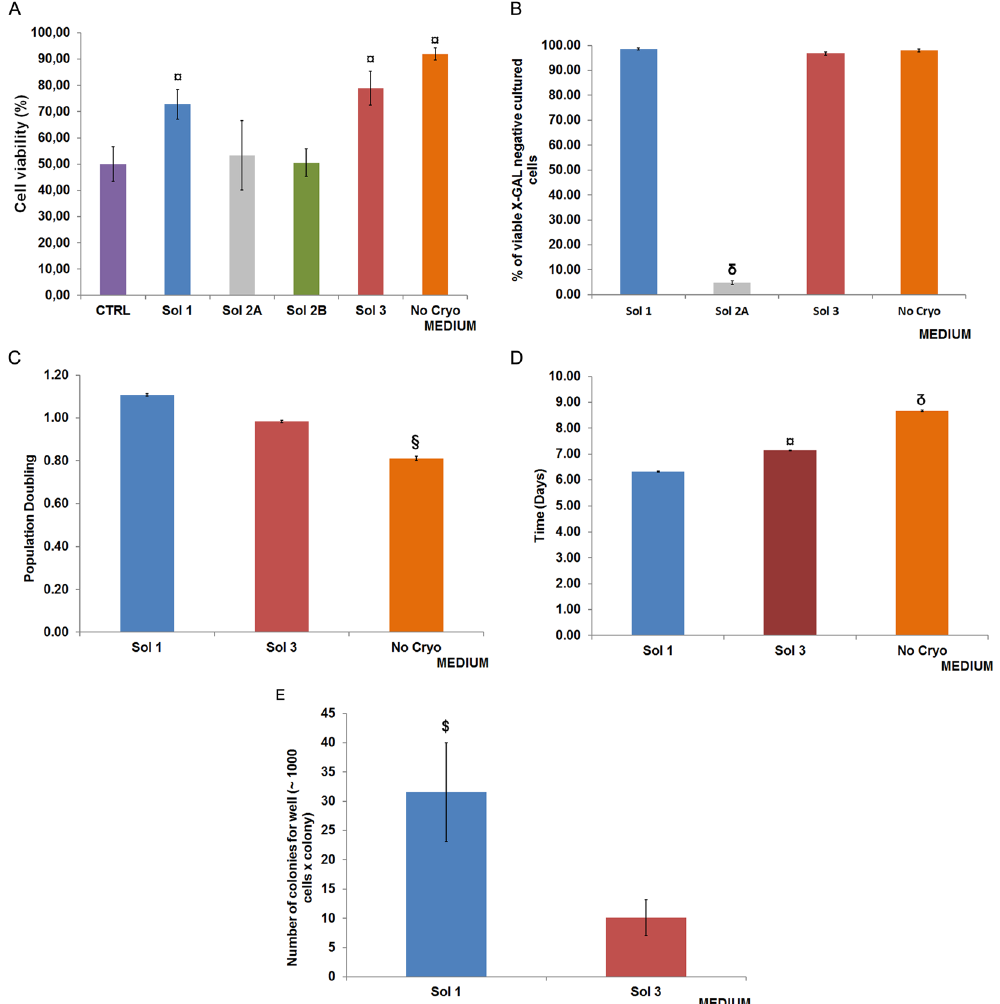
Figure 1. Biological cell functions after cryopreservation/thawing. ( A ) Cell viability was assessed by Trypan blue exclusion test after thawing the cells cryopreserved in different solutions (N = 9 experiments). Viability was significantly higher in solution 1 (Sol1) and Sol3 vs Sol2A, Sol2B, control solution (CTRL), and freshly isolated (No Cryo). No difference was found between Sol1 and Sol3. Data are expressed as mean ± SD of 9 experiments; ¤ p < 0.001 Sol1 and Sol3 vs Sol2A, Sol2B, and CTRL; ¤ p < 0.001 No Cryo vs all other Solution. Solution composition: Sol1 = Kubota Medium (KM), DMSO (10%), HSA (15%), hyaluronic acid (0.1%W/V); Sol2A = KM, hyaluronic acid (HA)(0.1%W/V), DMSO (10%); Sol2B = KM, HA (0.05% W/V), DMSO (10%); Sol3 = KM, DMSO (10%), HSA (15%); CTRL = KM, DMSO (10%), HSA (1.5%). ( B ) Cell senescence was evaluated by X-Gal test in cultures obtained from cryopreserved or freshly isolated cells (No Cryo) obtained from the same donors. Graphics show the percentage of X-Gal negative cells (non senescent cells). X-Gal negative cells exceeded 95% after cryopreservation. No difference was observed between Sol1 and Sol3, and among cryopreserved cells and fresh control cells (No Cryo). Sol2A demonstrated a massive senescence of cultured thawed cells ( δ p < 0.0001 vs others). Data are expressed as mean ± SD of 3 experiments. ( C ) Proliferation rate expressed as population doubling (PD) week rate in cultures of hBTSCs cryopreserved in Sol1, Sol3, and freshly isolated controls (No Cryo). Cryopreserved cells (Sol1 and Sol3) demonstrated a higher PD week rate with respect non-cryopreserved cells ( § p < 0.01). Data are expressed as mean ± SD of 8 experiments. ( D ) Population Doubling Time (PDT) appeared lower in Sol1 (with HA) than Sol3 (without HA) and freshly isolated controls (No Cryo)( ¤ p < 0.001 vs others), and in Sol3 vs freshly isolated controls (No Cryo) ( p < 0.0001 vs No Cryo). Data are expressed as mean ± SD of 8 experiments. E) The number of colonies was counted at day 3 of culture. HA-coated hBTSCs and uncoated hBTSCs were compared. Graphics illustrate the number of colony formed after thawing cells cryopreserved in Sol1 and Sol3. A higher number of colonies (31.56 ± 8.43) developed in cultures from Sol1 than Sol3 (10.11 ± 3.85)( $ p < 0.000001). Data are expressed as mean ± SD of 18